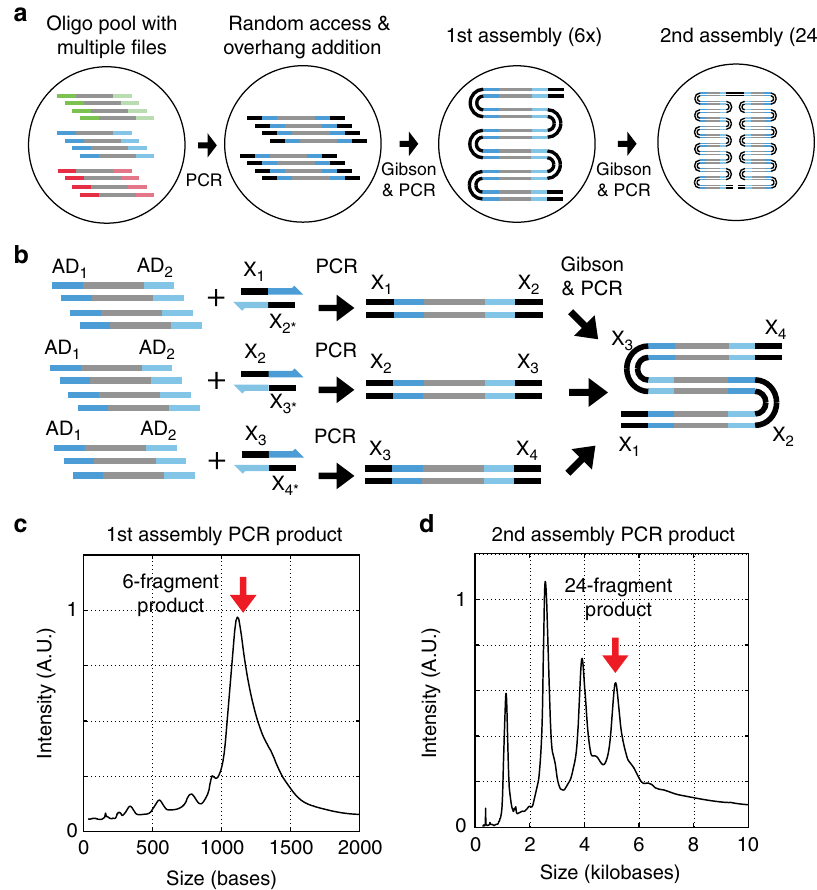
Fig. 2 Random access and sequential Gibson strategy for DNA storage. a Our sequential Gibson Assembly strategy enables random access and concatenation of any particular fi le from a pool of DNA oligonucleotides. We demonstrated up to 24-fragment assembly by performing two sequential assemblies of 6 and 4 fragments, respectively. b First, a given fi le is PCR-ampli fi ed using primers speci fi c to its address (AD1 and AD2) and containing overlapping overhang sequences (Xn). For a three-fragment assembly, three separate PCR ampli fi cation reactions are carried out, each containing primer pairs with different overhangs based on a sequential assembly design (X1 and X2*, X2 and X3*, and X3 and X4*). Upon ampli fi cation, products are puri fi ed and combined by Gibson Assembly. The assembly product can consist of any combination of oligonucleotides in a given fi le pool separated by ordered overhangs with a consistent directionality (e.g., X1-AD1-Payload1-AD2-X2-AD1-Payload2-AD2-X3-AD1-Payload3-AD2-X4). This product is then ampli fi ed by using primers speci fi c to ends of the assembly (X 1 and X 4 *) and can be used as the starting material for a second assembly. c Gel electrophoresis size distribution corresponding to a PCR ampli fi cation of a 6-fragment Gibson Assembly. The expected band size was 1110 bp. d Gel electrophoresis size distribution corresponding to a PCR ampli fi cation of a 24-fragment second Gibson Assembly. The expected band size was 4590 bp. The correct